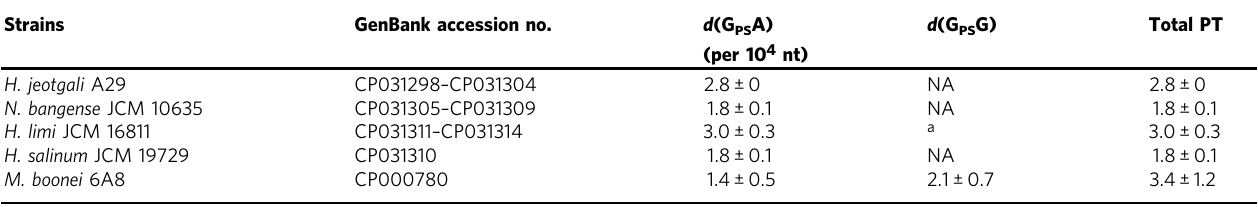
Values represent the mean±SD of three analyses of 10 μ g of archaeal DNA. Source data are provided as a Source Data fi le NA, not applicable a Indicates that the PT-linked dinucleotides were detected but were below the limit of quanti fi cation